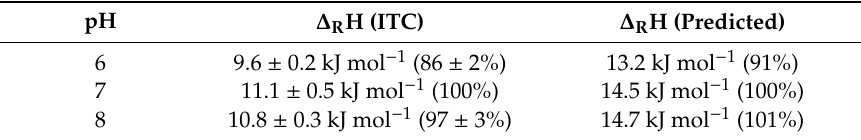
Table 1. Comparison of measured and predicted reaction enthalpy change.